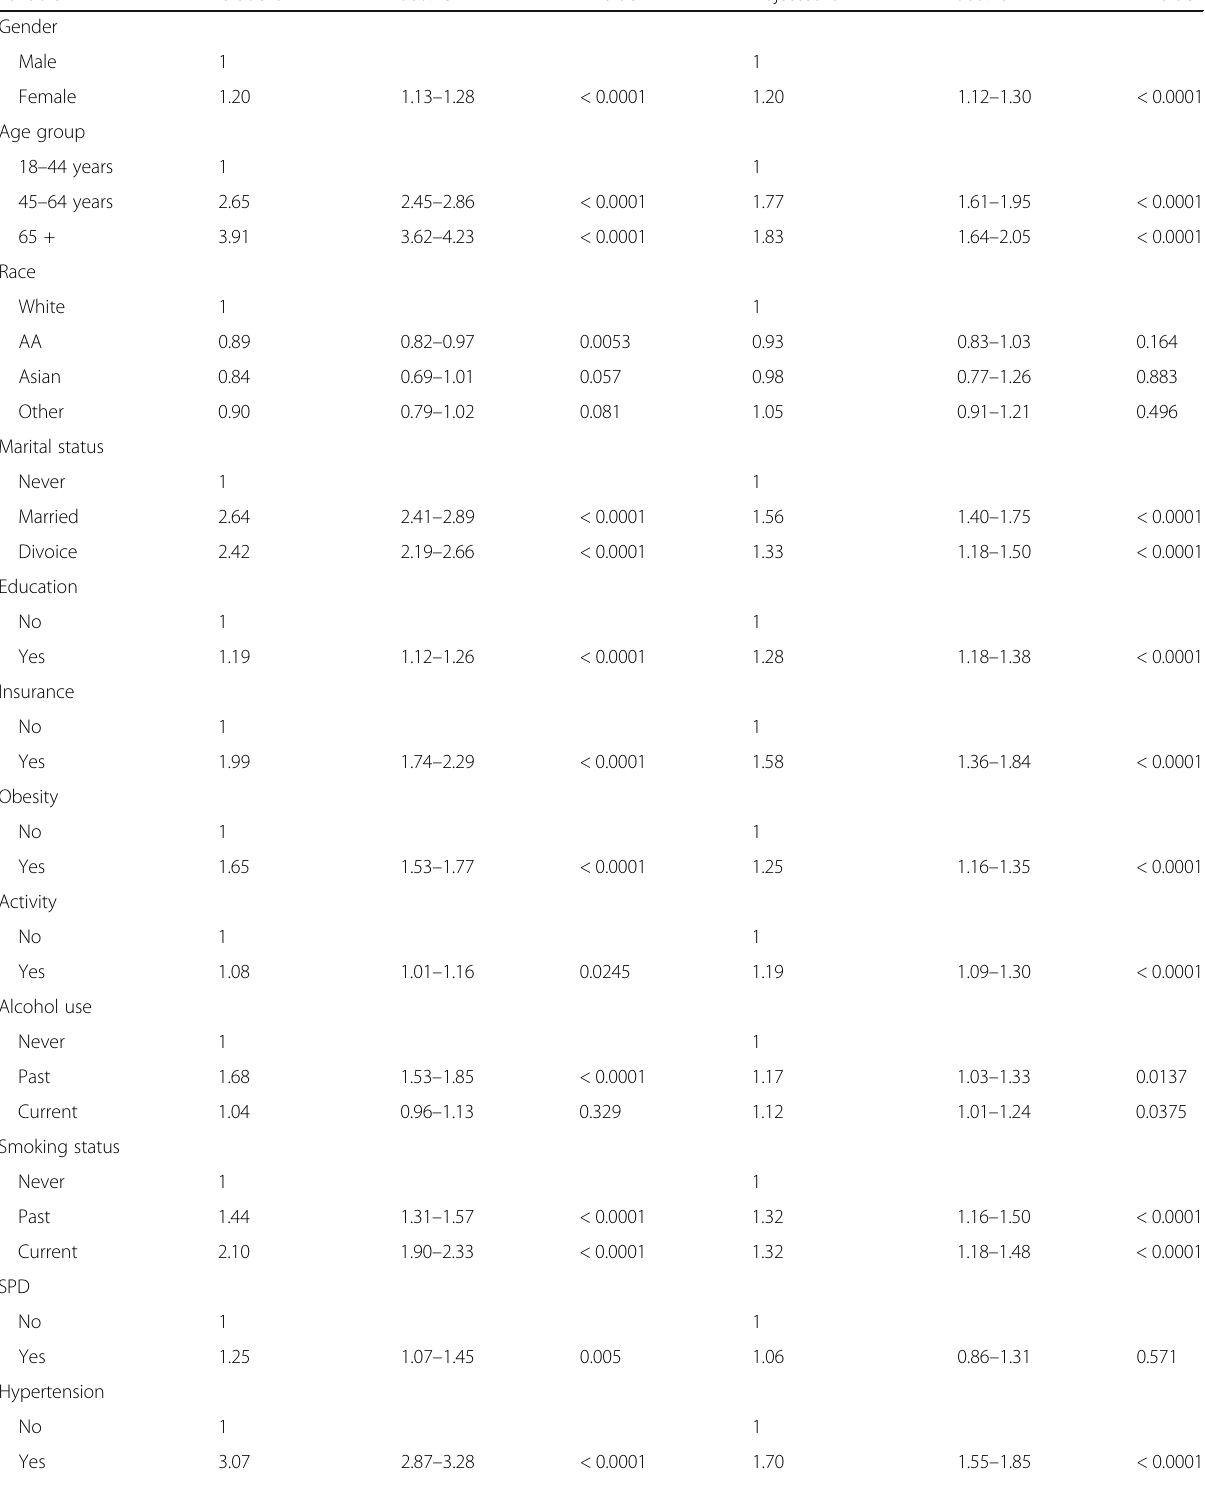
Table 2 Univariate and multiple logistic regression analyses for the relationship between potential factors and type 2 diabetes screening